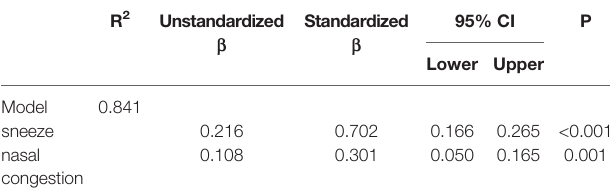
TABLE 2 | Regression statistics for a stepwise regression of allergic rhinitis- relevant predictors on allergen immunotherapy (AIT) results, fi nal model. R